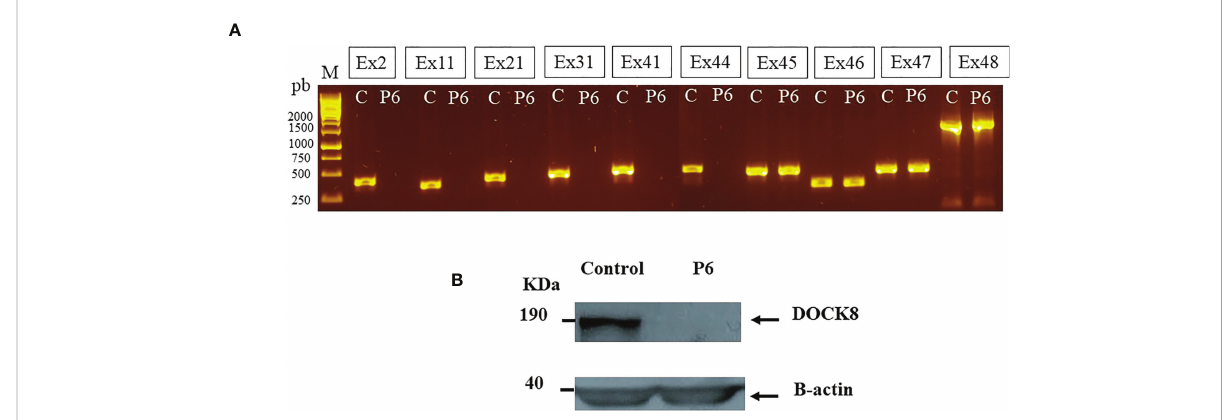
FIGURE 3 DOCK8 (Ex1-Ex44) deletion in P6 (A) Lack of PCR products from DOCK8 genomic DNA suggesting exonic deletions up to exon 44 (B) DOCK8 protein expression was evaluated in P6 by Western blot in denaturated whole-cell lysates from EBV transformed cell lines, using anti-DOCK8